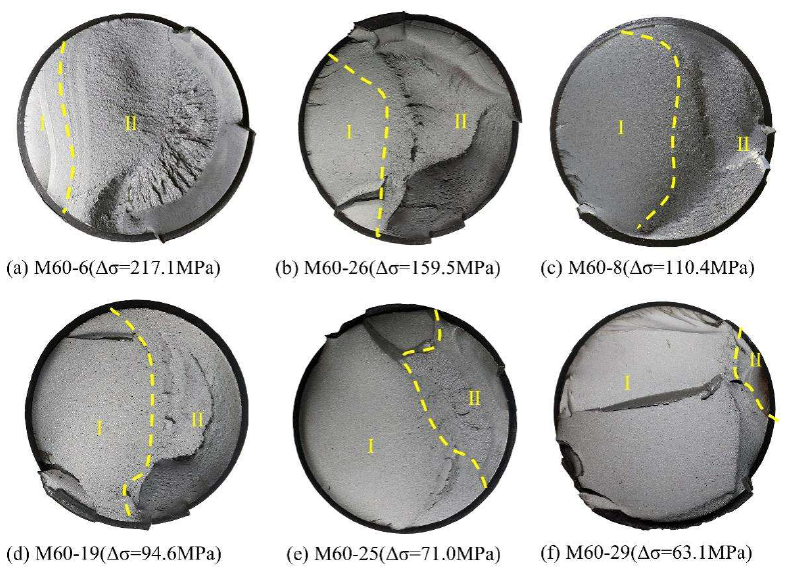
Figure 11. Macroscopic fracture morphology of the representative high-strength bolts: I indicates the crack propagation area, and II represents the transient fracture area.